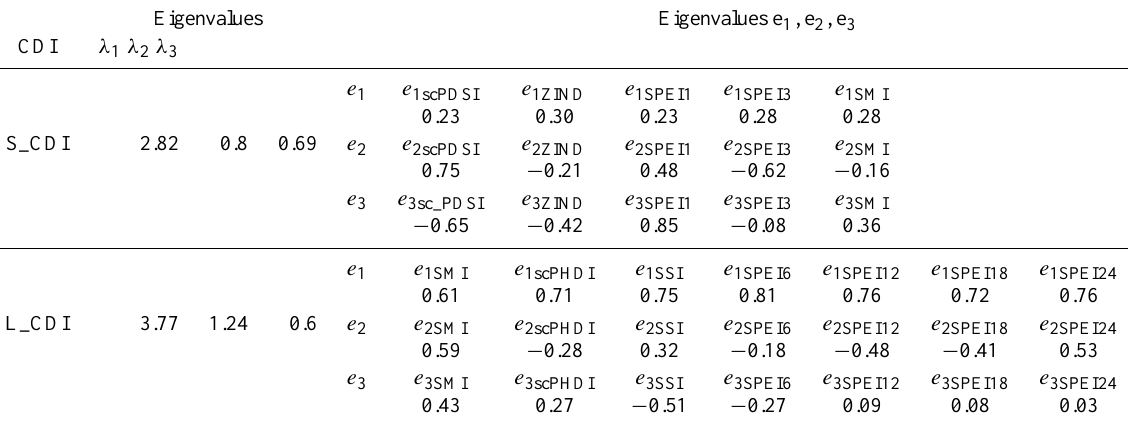
Table 2. Drought categories of the short-term/long-term CDI. Drought Category Short-term CDI Long-term CDI Normal ( − 0.37, +∞ ) ( − 0.33, +∞ ) Mild drought ( − 0.69, − 0.37] ( − 0.78, − 0.33] Moderate drought ( − 0.97, − 0.69] Severe drought Extreme